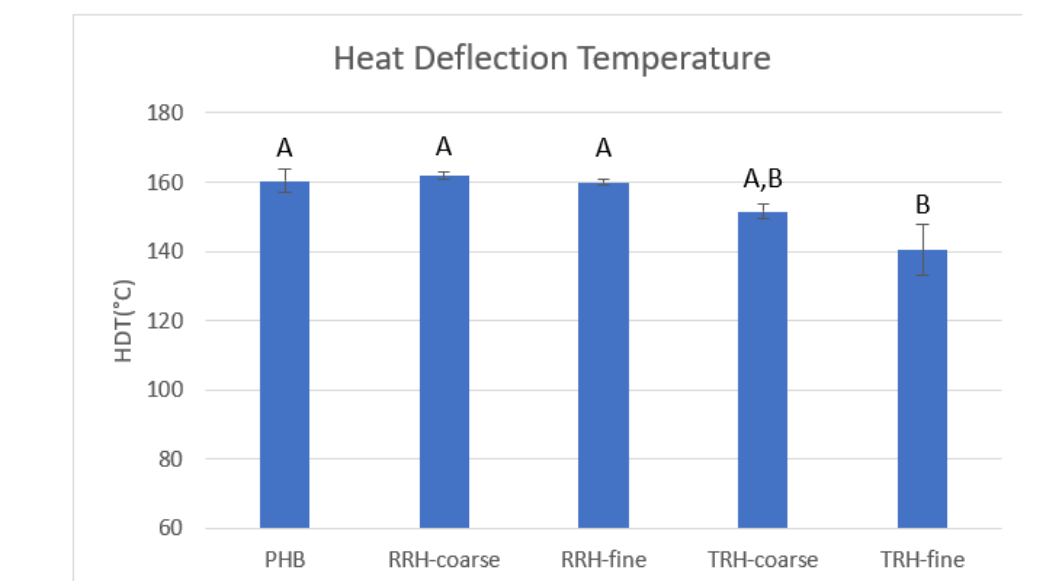
Figure 10. FTIR absorbance spectra of (top) PHB, (middle) raw rice hulls (RRH), and (bottom) torrefied rice hulls (TRH).